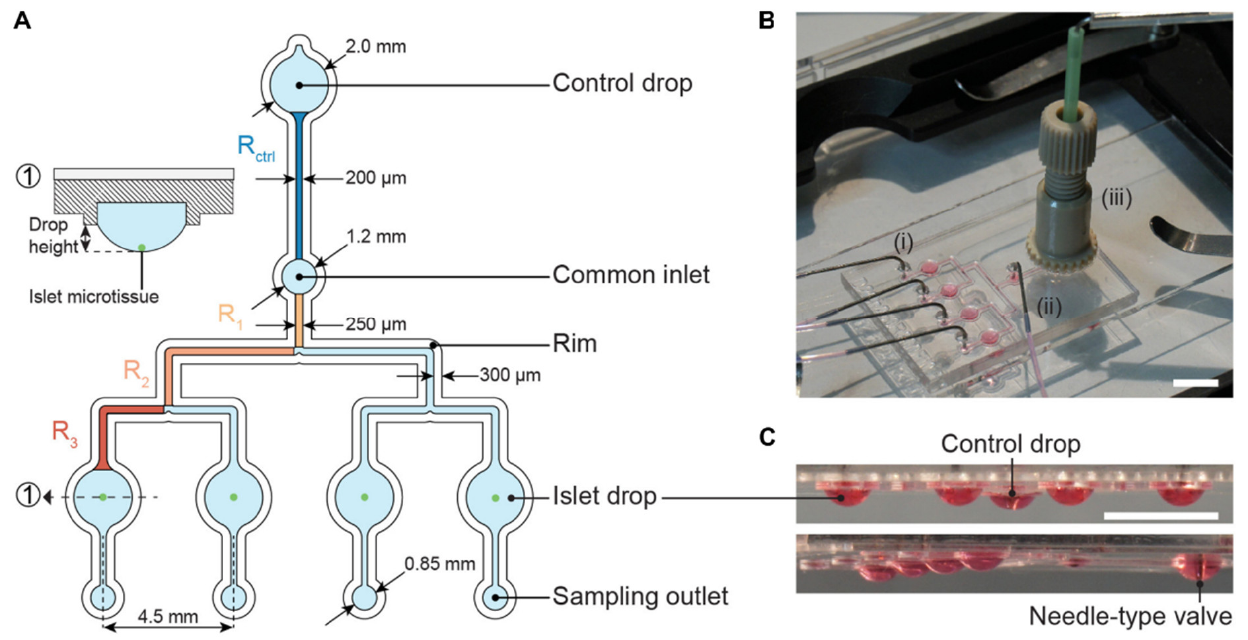
Figure 9. Microfluidic hanging-drop perifusion system. ( A ) Chip layout and dimensions. The fluidic structures (light blue) have a depth of 500 μm, except for the common inlet that has a recess depth of 1 mm. The hydrophobic rim structures (white) defined the fluidic channels and hanging drops. They had a height of 250 μm measured from the chip surface. Highlighted channel sections in dark blue and orange were considered for the calculation of the hydraulic resistance in the channels. The channels between common inlet and control drop and between common inlet and islet drops were designed to have the same hydraulic resistance. (1) Cross-sectional view of the islet drop with the islet microtissue at the bottom of the hanging drop. ( B ) Top view of the assembled chip with (i) four parallel outlet tubes, (ii) one common inlet tube, and (iii) a NanoPort assembly with a needle-type valve inserted at the center. Scale bar: 10 mm. ( C ) Side views of the chip with hanging drops visualized with red dye. All hanging drops had equal sizes and shapes. Scale bar: 5 mm. Reproduced from Wu Jin et al. [10] (CC BY 4.0).